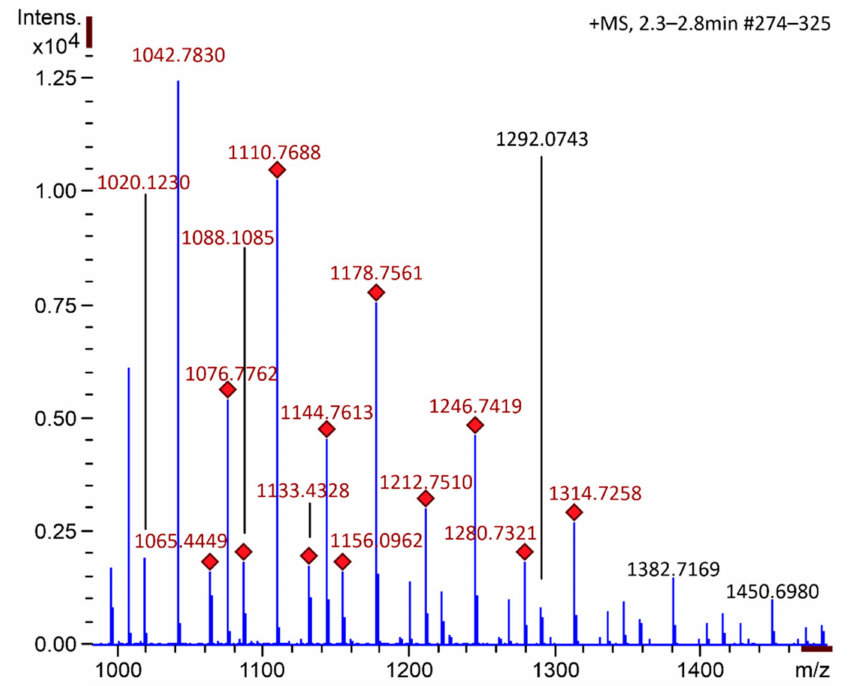
Figure 2. Mass spectrum with an emphasis on the m/z region between 950 and 1500 obtained for the peak present in fraction G1 of sample COS1 at the retention times of 2.3 to 2.8 min with subtraction of the baseline.